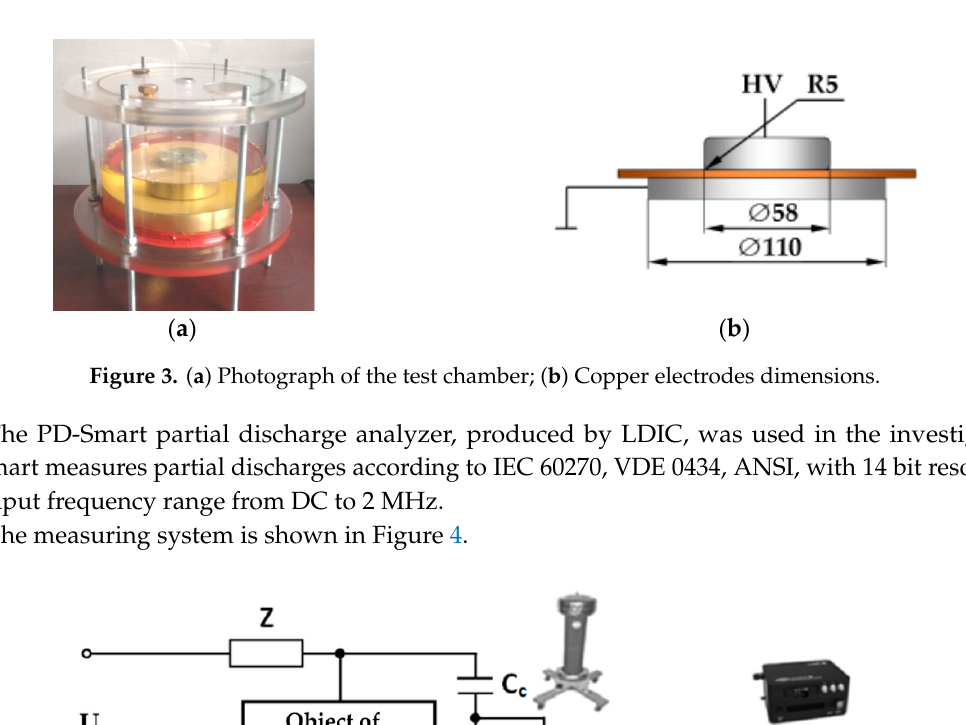
Figure 4. Measuring setup; C c — coupling capacitor, CC 1000/40, LDIC; Z m — measuring impedance, LDM — 5/U, LDIC; PD detector — PD Smart, LDIC.